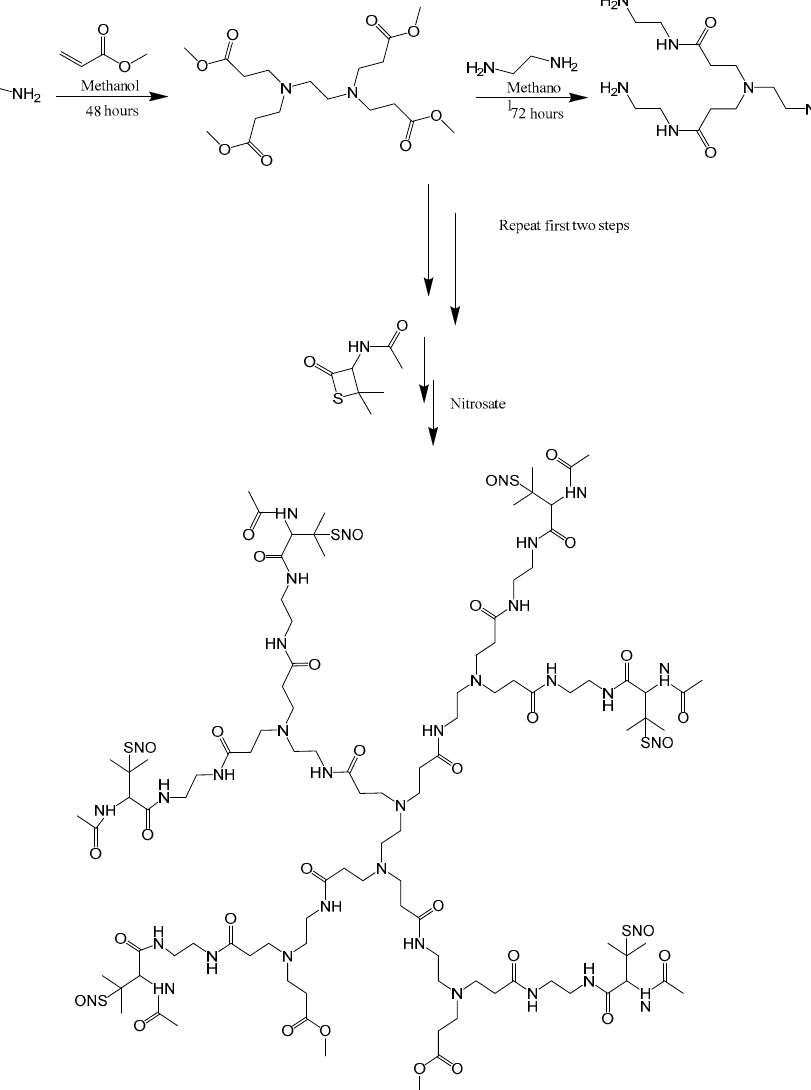
Figure 1. Illustration of the synthetic scheme of generation 2 SNAP-HPAMAM.